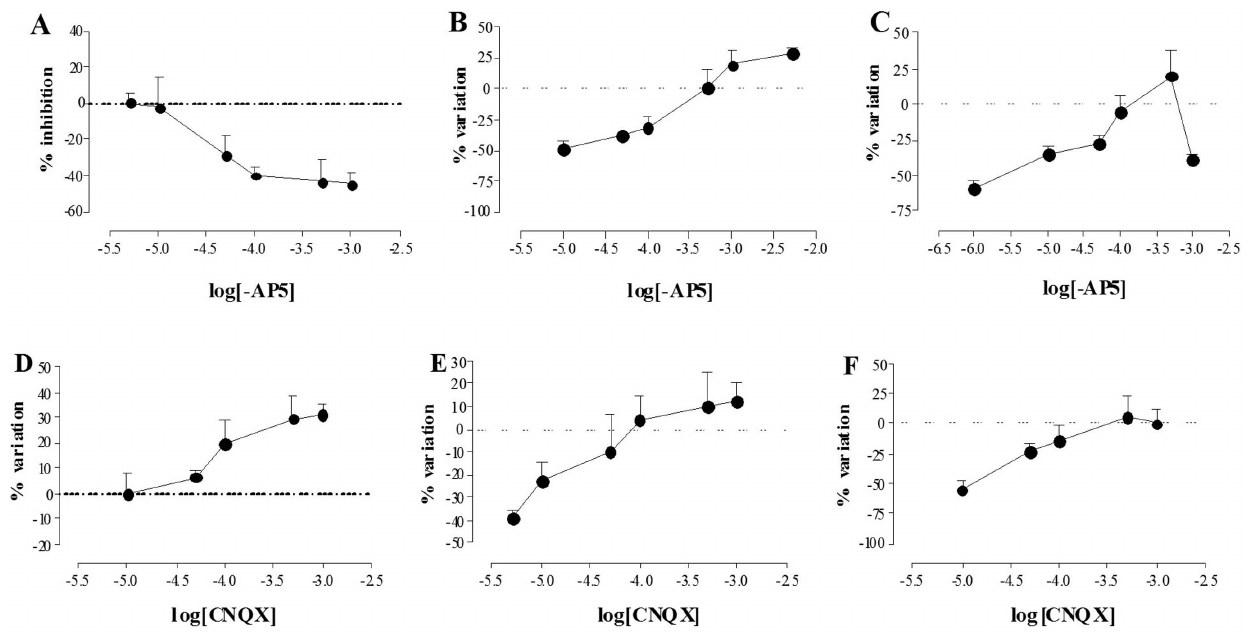
Figure 4. Effect of NMDA and AMPA/kainate receptor blockade on myenteric neuron count after I/R damage. Concentration-response curves represent the effect of -AP5 (A-C) and CNQX (D–F) on the number/mm 2 of myenteric neurons obtained from rat small intestine after inducing chemical ischemia (B, E) and after reperfusion (C, F) with respect to values obtained in normal metabolic conditions (A, D). Percentage variation of neuron number/ mm 2 is plotted against log molar concentrations of -AP5 (A-C) and CNQX (D–F). Each point represents the mean of 4 experiments. Vertical bars indicate